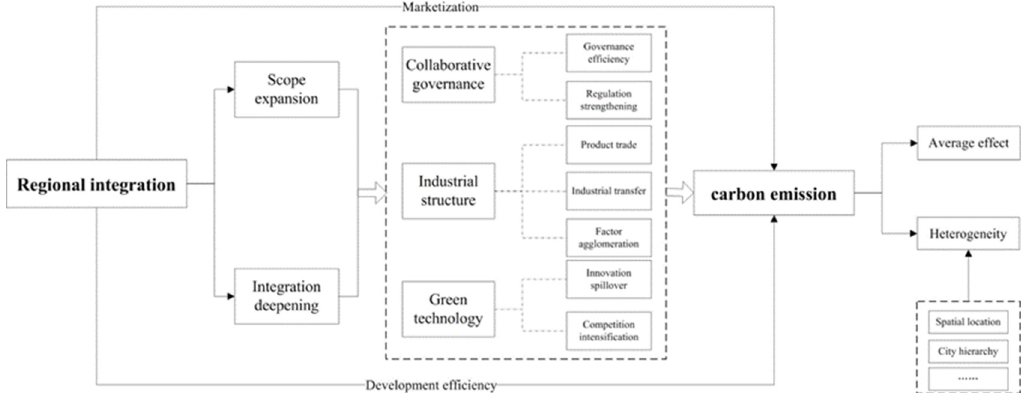
Figure 1. Regional integration and carbon emission linkage mechanism.